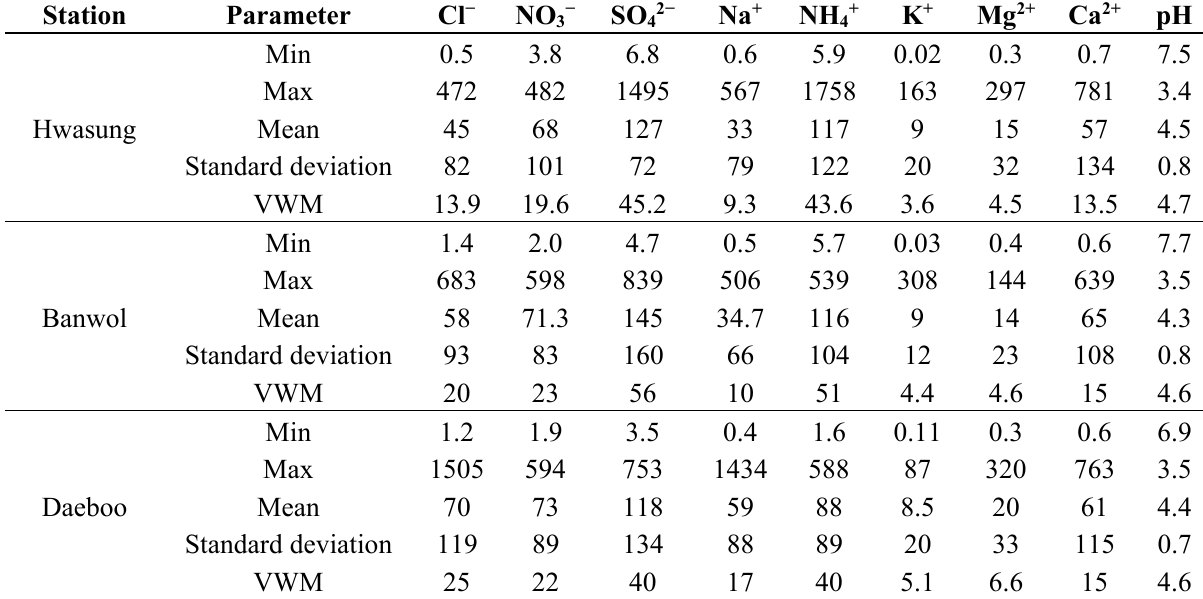
Table 2. Major ionic compositions of precipitation in the Shihwa Basin (µeq·L − 1 except pH). Station